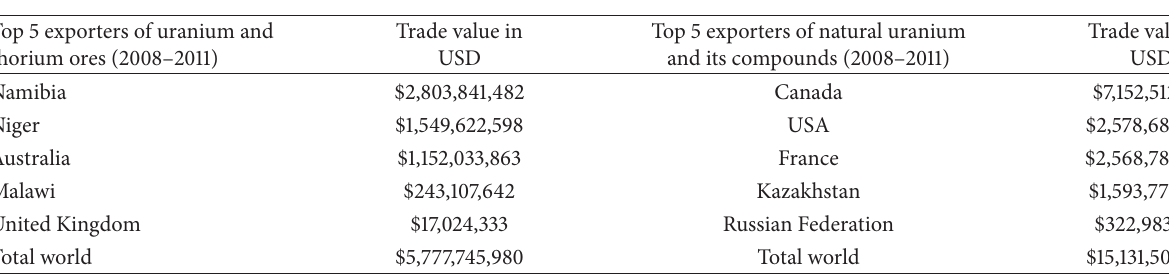
Table 1: Top 5 exporters of uranium ore, natural uranium, and enriched uranium between 2008 and 2011. (a)